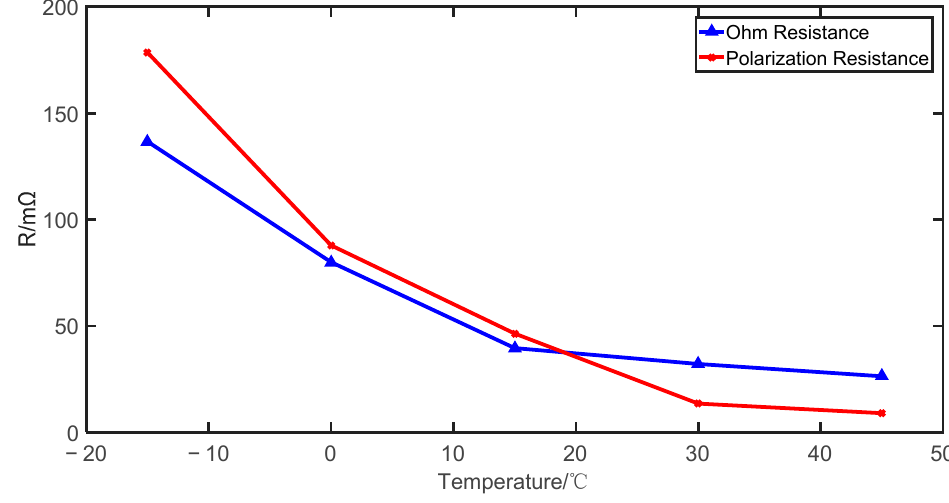
Figure 5. The Ohmic resistance and polarization resistance of batteries.